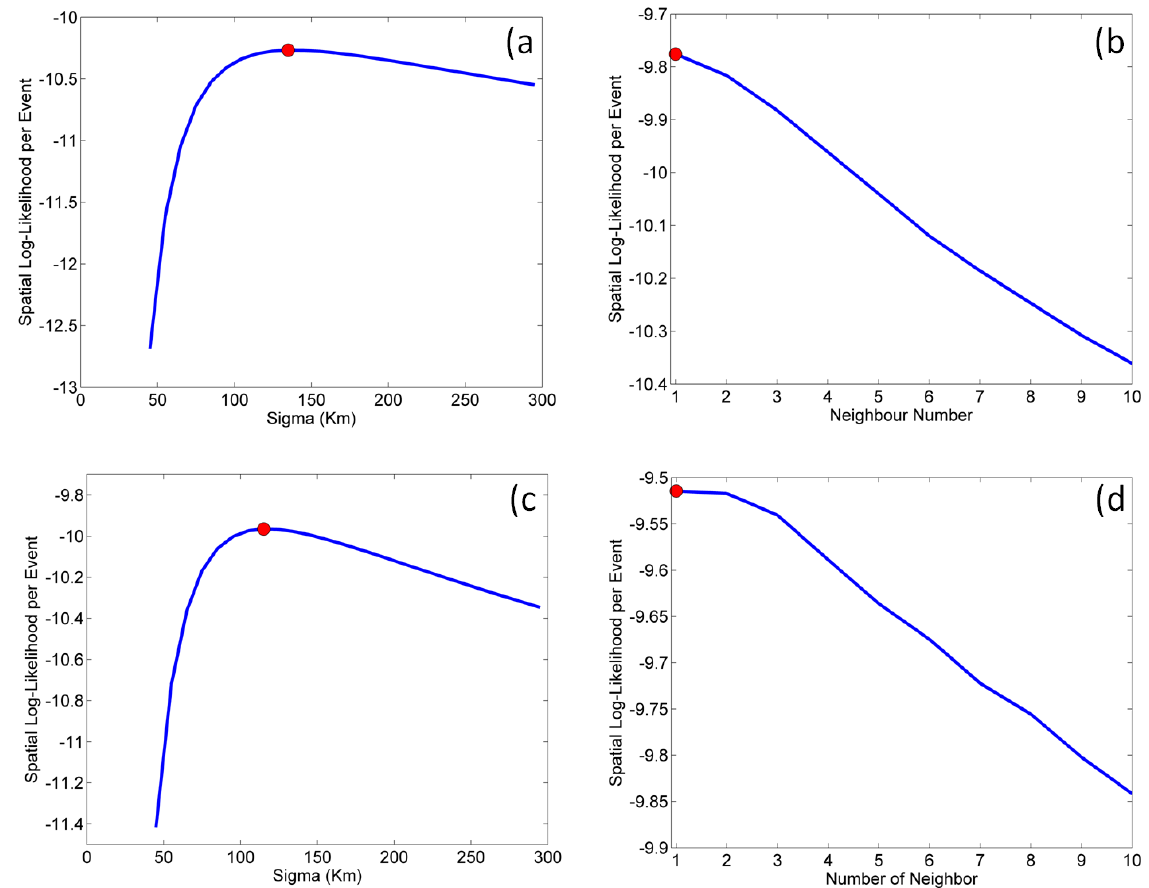
Figure 3. MLE for the parameters sigma and NN for the Fixed ( a ), Adaptive ( b ), Fixed corrected ( c ), and Adaptive corrected ( d ) models. Blue curves represent the log-likelihood functions, red dots the maximum of these functions.